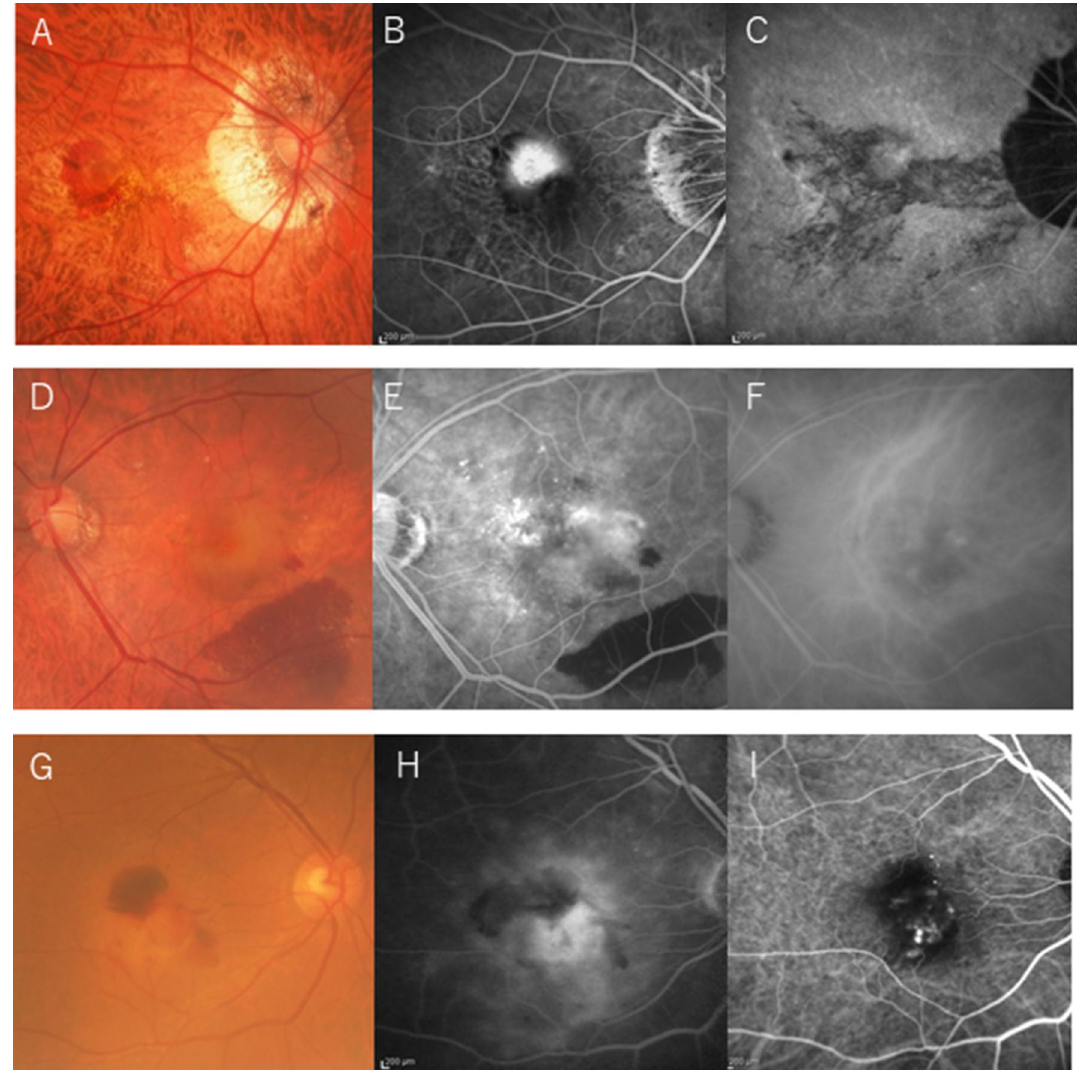
Figure 1. Representative cases of the three groups. ( A – C ) The mCNV group has more severe chorioretinal atrophy than diffuse choroidal atrophy ( A ), fluorescein angiography (FA) shows classic CNV ( B ), and ICGA shows LCs ( C ). ( D – F ) The high-myopia CNV group shows no chorioretinal atrophy (MM less than category 2) ( D ), FA shows occult CNV and blockage due to subretinal hemorrhage ( E ), and ICGA shows polyp lesions ( F ). ( G – I ) The AMD group has an AL of less than 26.5 mm, no chorioretinal atrophy on fundus photography ( G ), occult CNV on FA ( H ), and polyp lesions on ICGA ( I